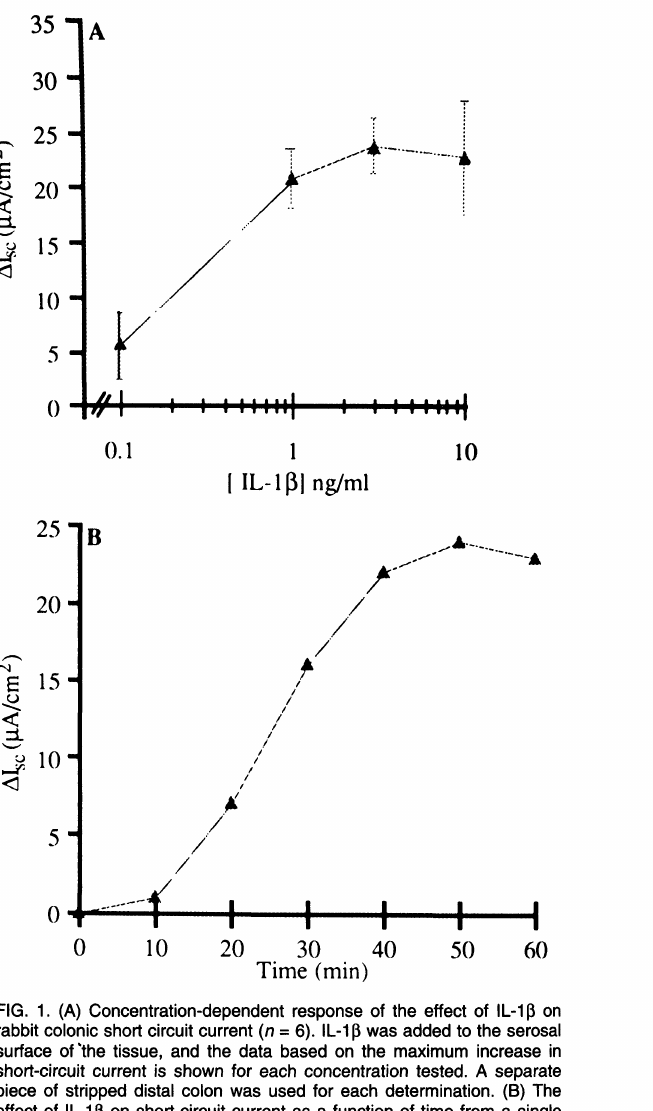
FIG. 1. (A) Concentration-dependent response of the effect of IL-I on rabbit colonic short circuit current (n 6). IL-1 was added to the serosal surface of’the tissue, and the data based on the maximum increase in short-circuit current is shown for each concentration tested. A separate piece of stripped distal colon was used for each determination. (B) The effect of IL-I on short-circuit current as a function of time from a single representative